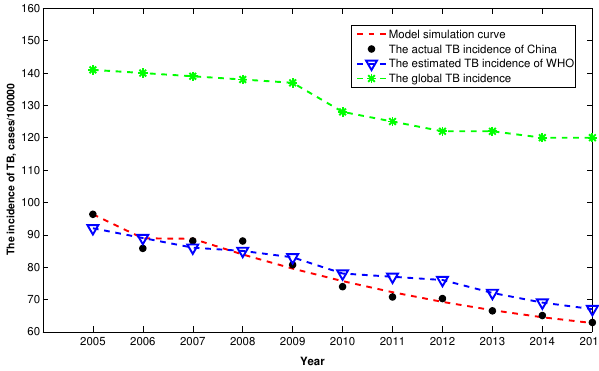
Figure 5. The comparison of TB incidence from 2005 to